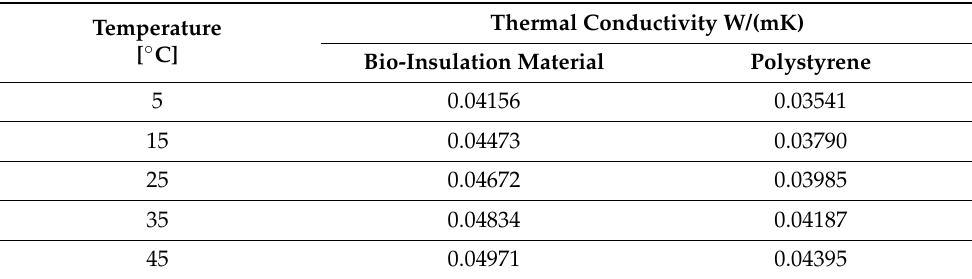
Table 2. The thermal conductivity values for puffed rice insulation and polystyrene insulation sam- ples.